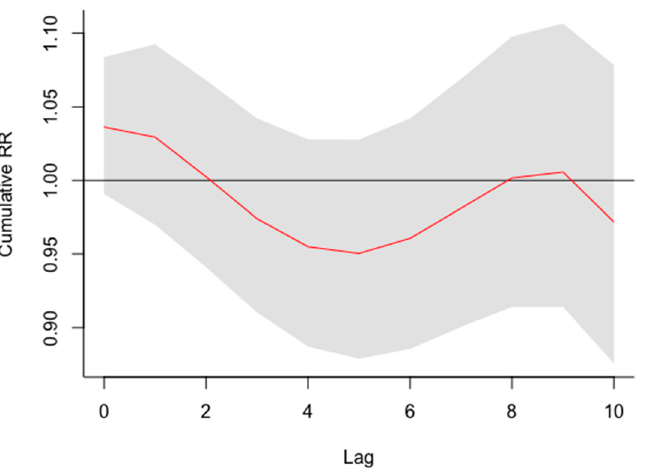
Figure 4. Cumulative effect associated with a 10 µ g/m 3 increases in the API over 10 days on admissions for chronic respiratory disease.